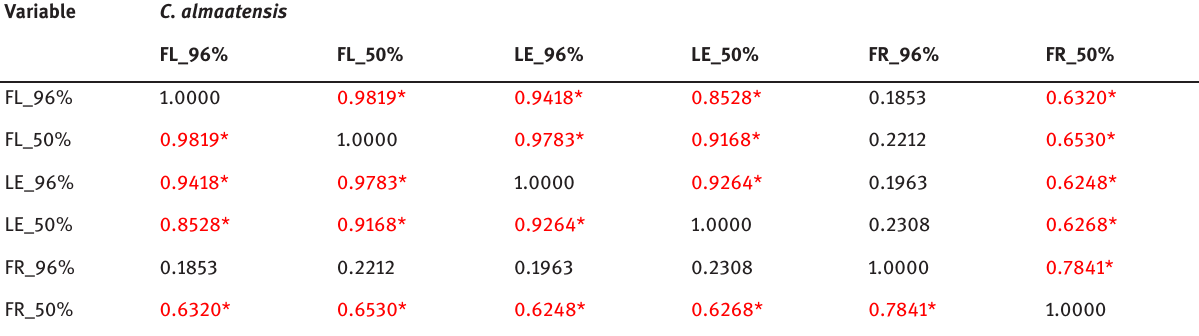
Table 3: The correlation values obtained for all tested extracts. Variable